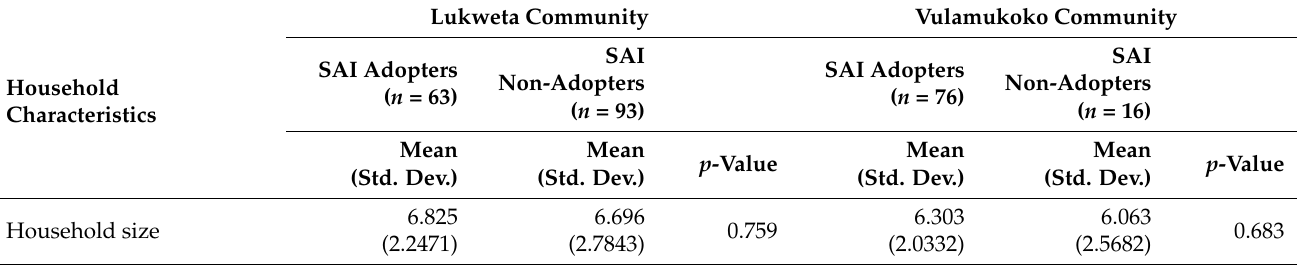
Table 1. Socioeconomic and demographic characteristics of the study households, by SAI adoption.